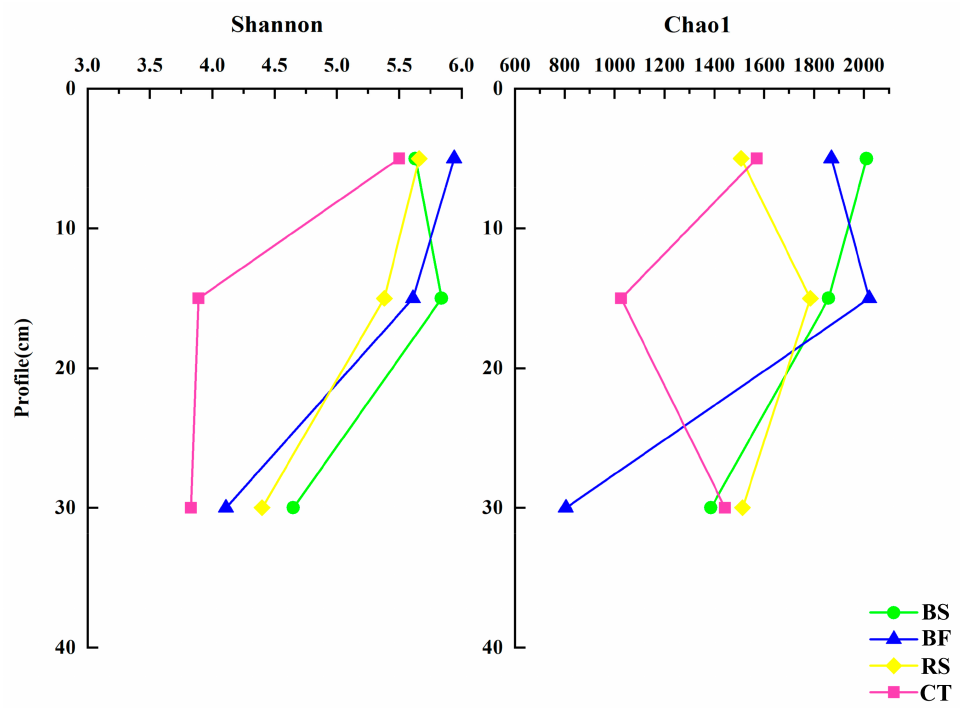
Figure 1. Diversity and richness in soil bacteria communities along the soil profile under different soil and water conservation measures.